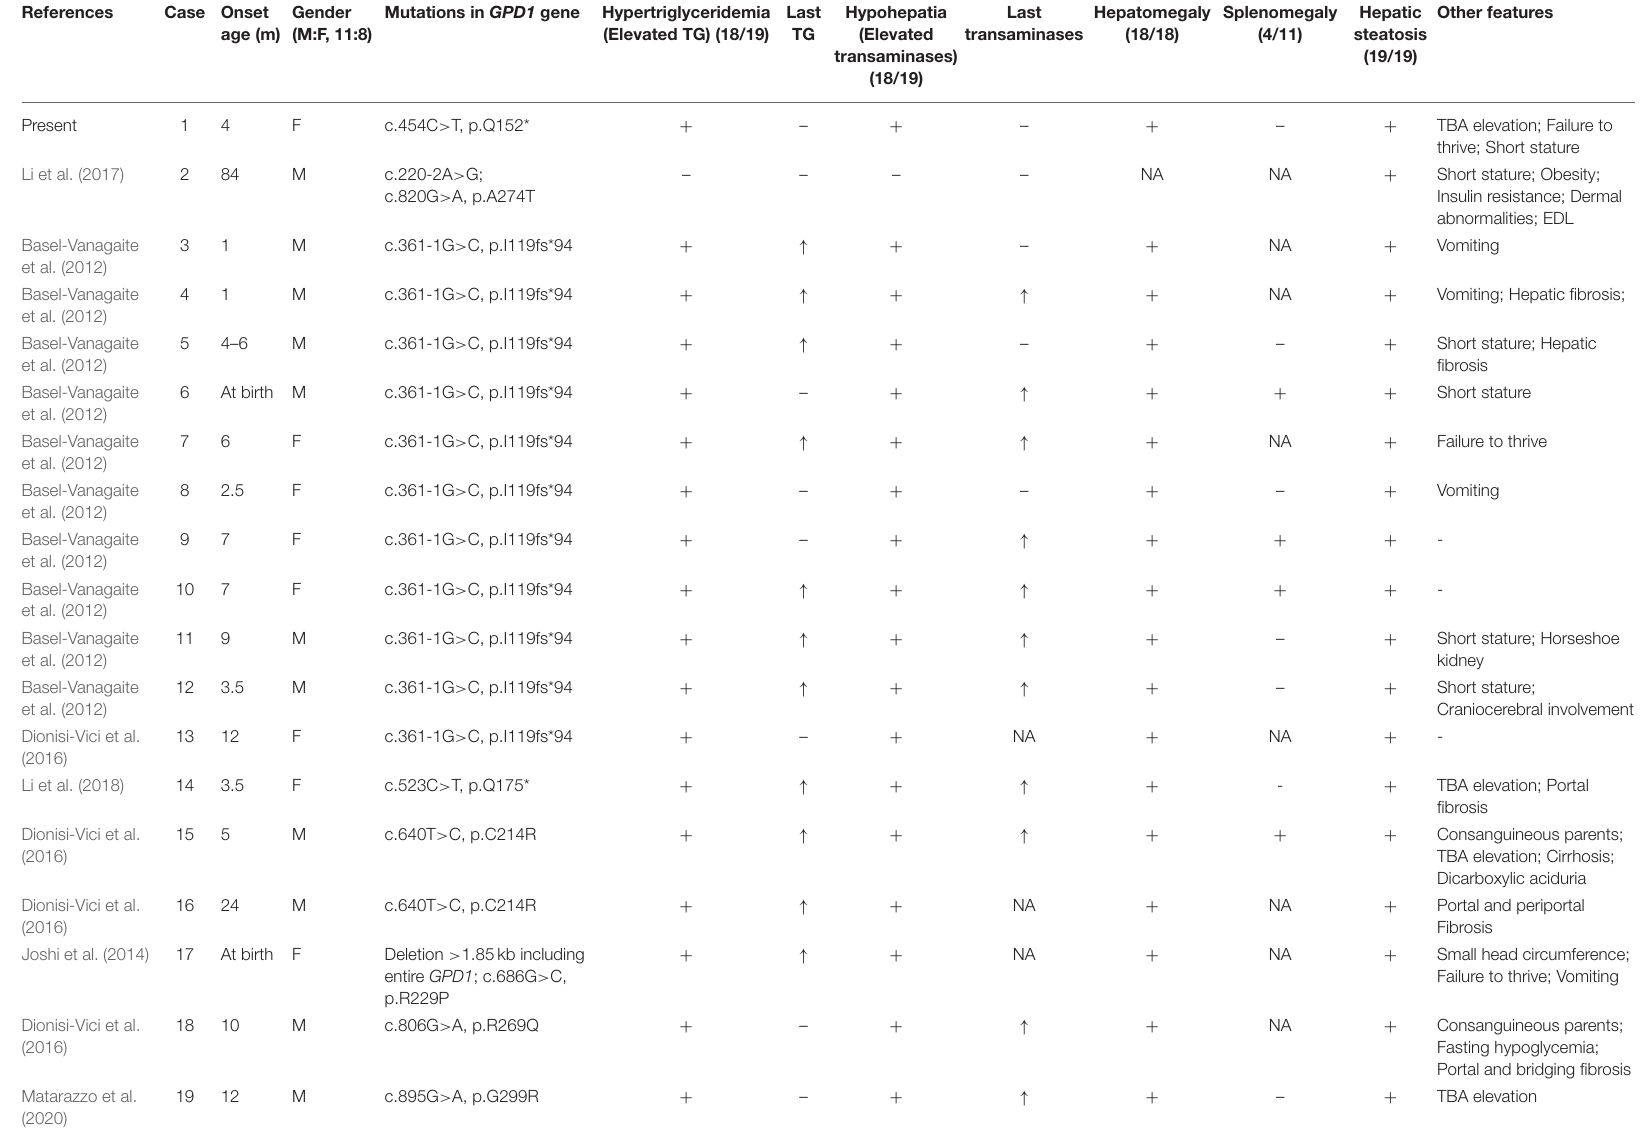
TABLE 1 | Clinical and genetic characteristics of GPD1 -associated 19 HTGTI patients whose data are